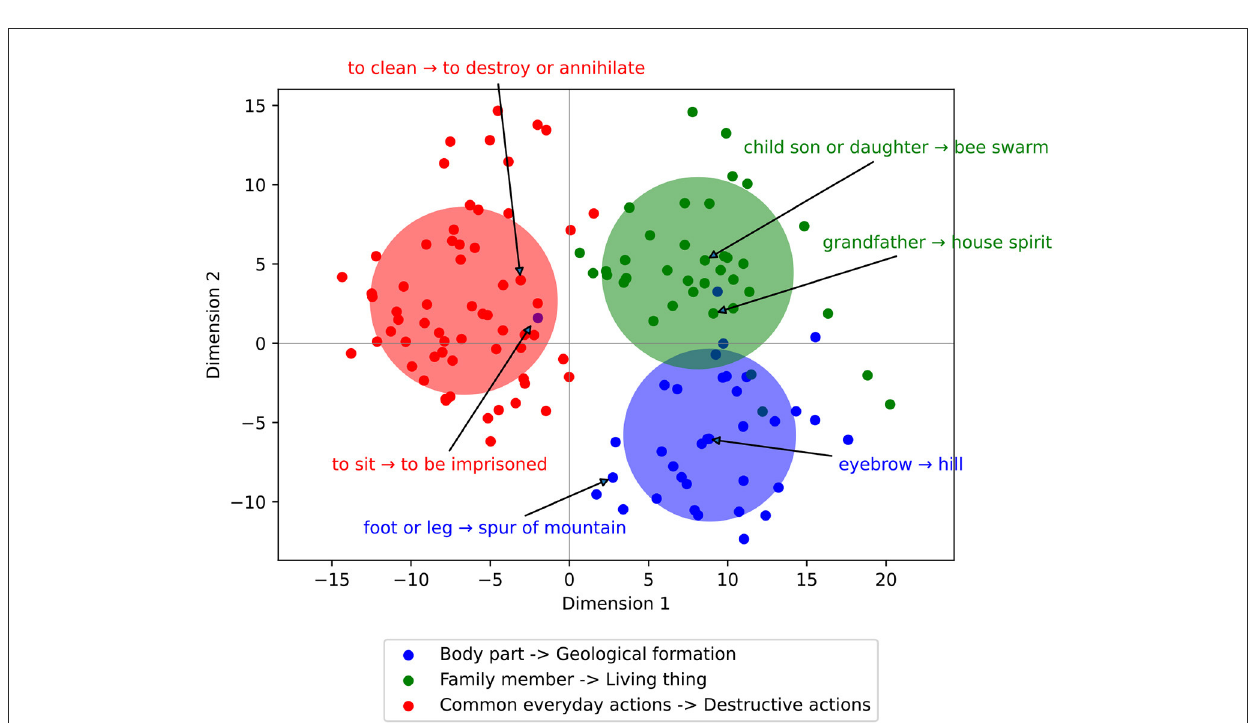
FIGURE6 Example clusters of semantic change in dimension-reduced principal components space. Clusters are obtained via a Gaussian mixture model and illustrate regular domain-domain mappings, where attested samples of semantic shift (source meaning → target meaning) are annotated.